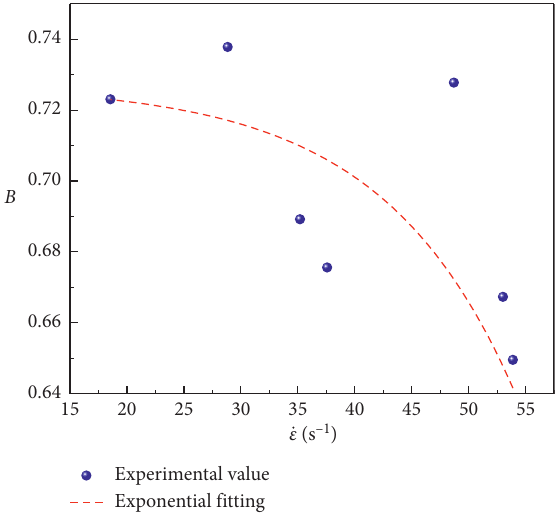
Figure 12: Strain rate effect on the brittleness